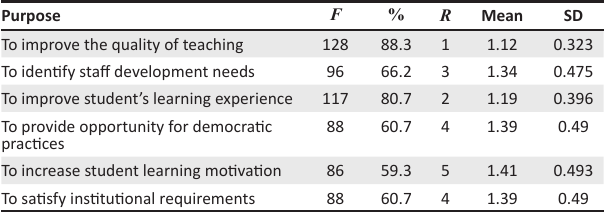
TABLE 2: The purpose of the evaluation of teaching. Purpose